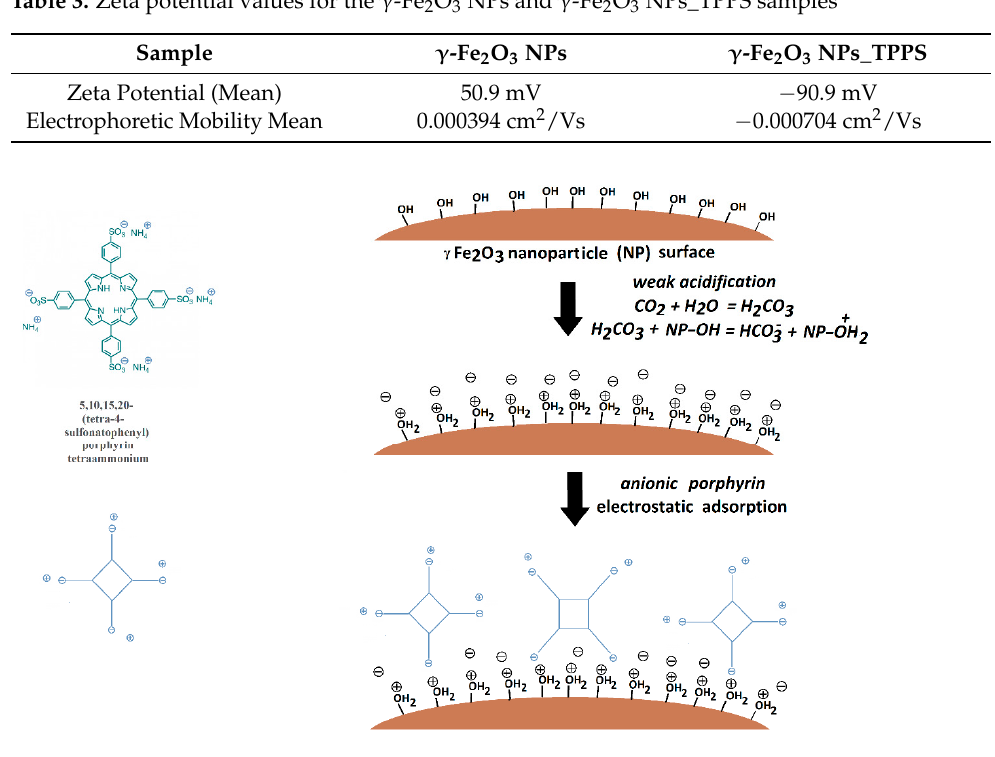
Figure 6. Schematic diagram of the adsorption process of the TPPS of the γ‐ Fe 2 O 3 surface. Table 3. Zeta potential values for the γ‐ Fe 2 O 3 NPs and γ ‐ Fe 2 O 3 NPs_TPPS